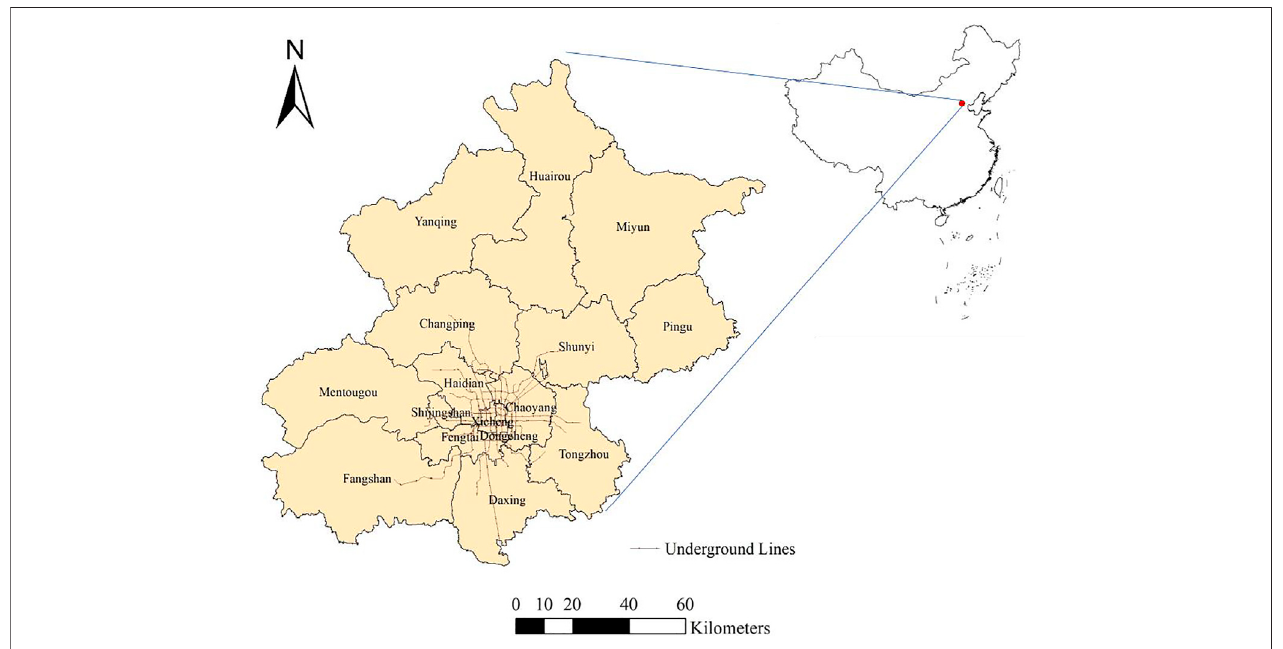
FIGURE 1 | Case study area.